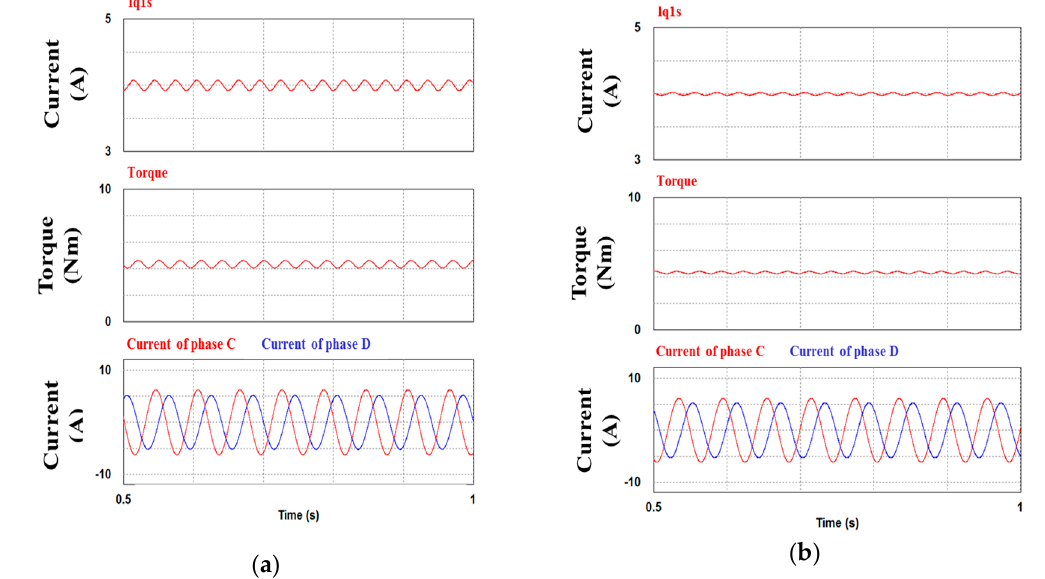
Figure 13. Simulation result of fault ‐ tolerant under open fault phases B in i q1s = 4 A and speed = 1000 rpm: ( a ) Without tolerant control; ( b ) With tolerant control.